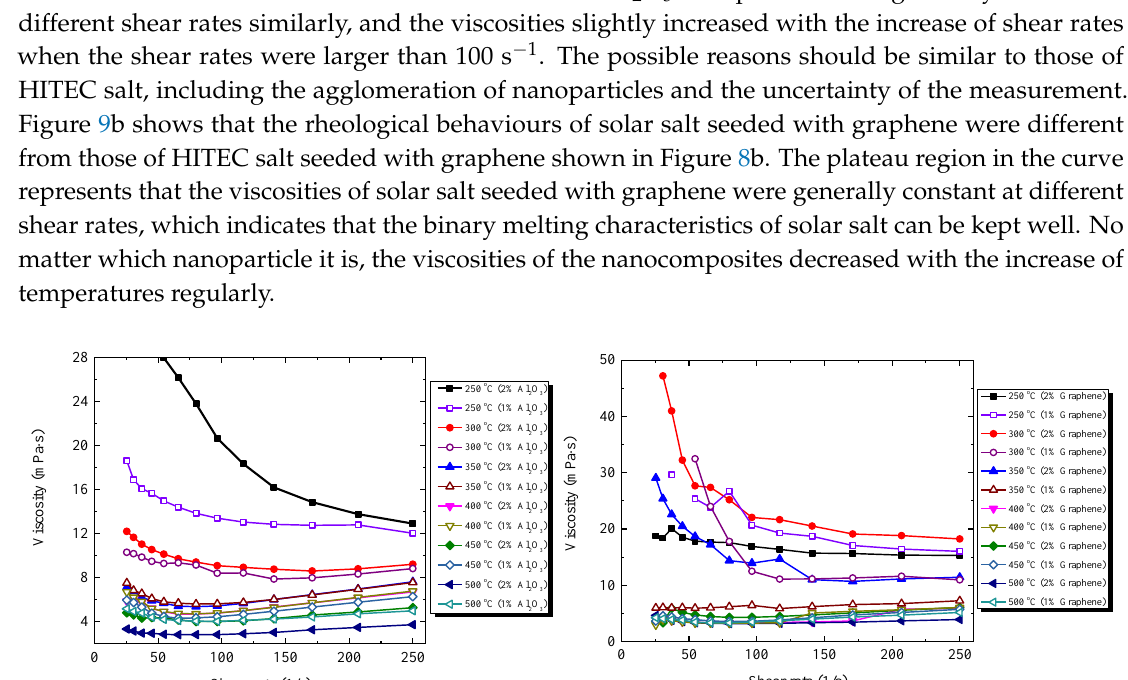
Figure 9. Viscosities of nanocomposites against different shear rates. ( a ) solar salt seeded with Al 2 O 3 nanopowder, ( b ) solar salt seeded with graphene. The addition of Al 2 O 3 nanopowder and graphene is with mass weight percentage.